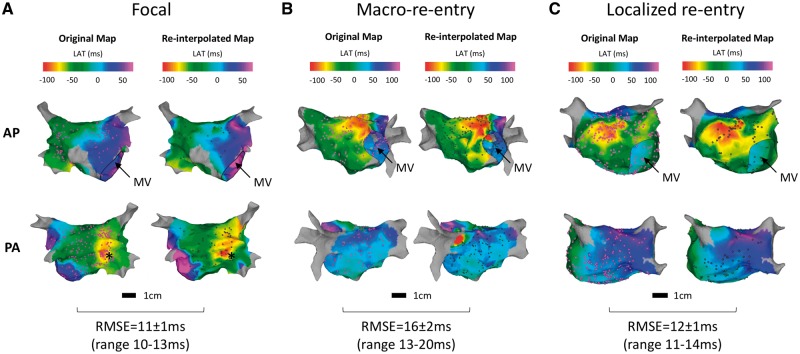
Clinical isochronal local activation time maps. Local activation time (LAT) maps for example clinical tachycardias are shown. Tachycardia mechanisms (confirmed by response to entrainment manoeuvres and to ablation) are given as headings in each column. (A) focal activation in low posterior LA; (B) perimitral macro-re-entry; (C) localized anterior re-entry. Anterior-posterior and posterior-anterior projections are shown (top and bottom row respectively). Left-most maps of each pair are the original isochronal maps produced at the time of the clinical procedure with purple dots representing sampled LAT point locations. Right-most maps of each pair are single examples of re-interpolated maps generated at the calculated optimal densities with black dots representing the re-sampled point locations. MV indicates the mitral valve annulus; * indicates the site of focal activation.